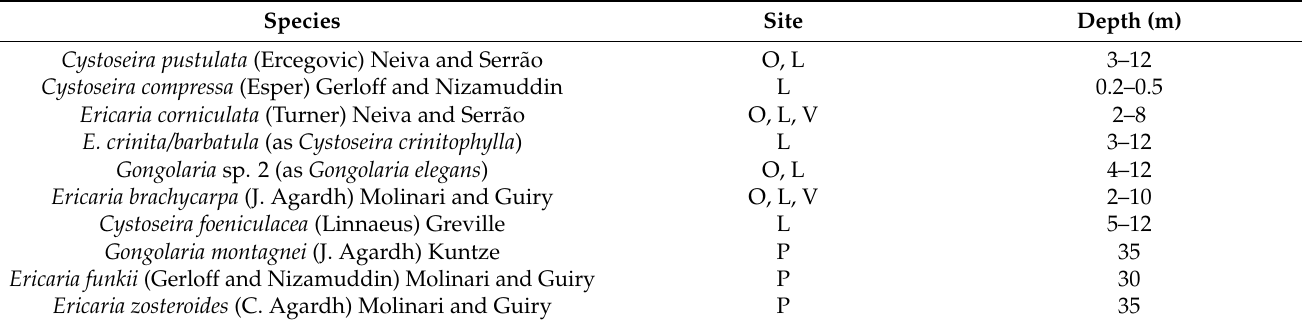
Table 2. List of Cystoseira s.l . taxa at the Santa Maria di Castellabate MPA. O = Ogliastro; L = Licosa; V = Vallone; P = Pagliarola.